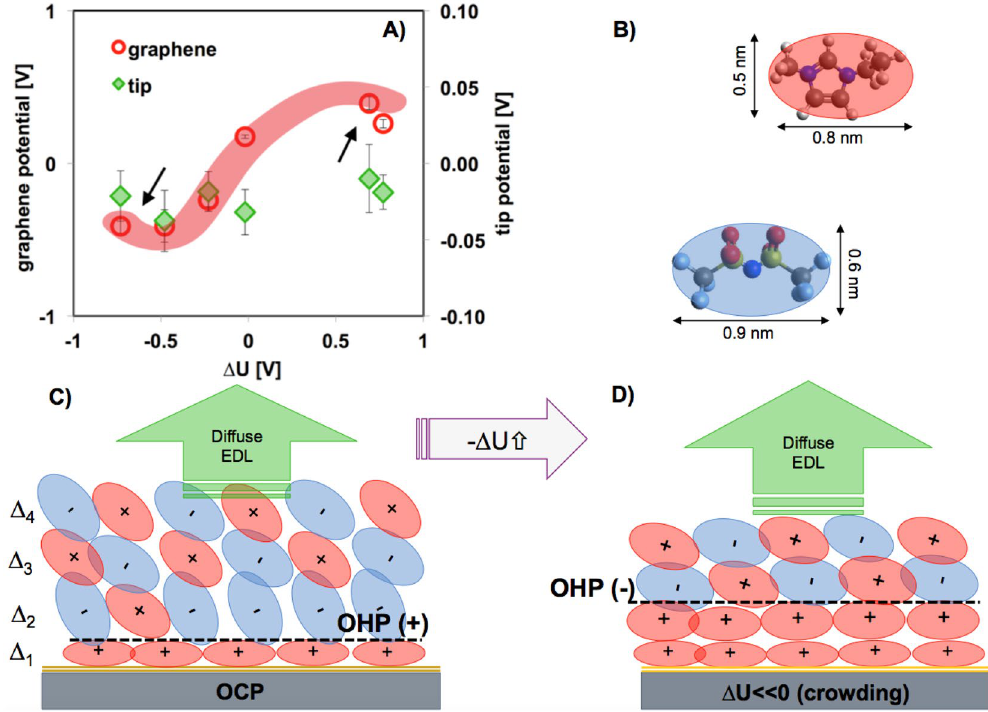
Figure 4. Proposed model for the EDL of [EMIM][TFSI] on graphene electrodes as a function of the potential. ( A ) The diagram shows the effective diffuse potentials on graphene and on the AFM tip. ( B ) Dim e nsions of cation and anion in the absence of nanoconfinement as calculated by the Avogadro software v.1.1.1. Proposed illustration of the EDL of [EMIM][TFSI] at OCP ( C ), and after the onset of crowding ( D ). The illustrations assume that the hard wall is at the graphene plane, and hence, it neglects a surface-bound layers of counterions that the AFM tip might not be able to remove at the highest load. A further simplification of the cartoon concerns the innermost layer at OCP, which might be cation rich instead of composed solely of cations. The accurate position of the OHP is also